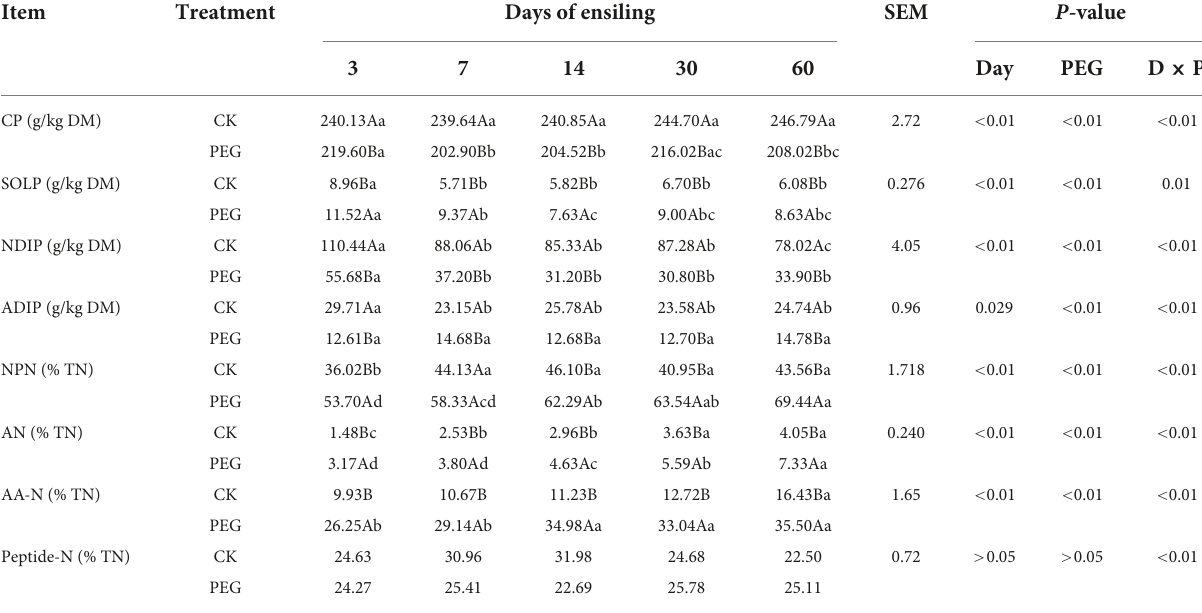
TABLE 1 Effects of intrinsic tannins on nitrogen distribution in sainfoin silage 1